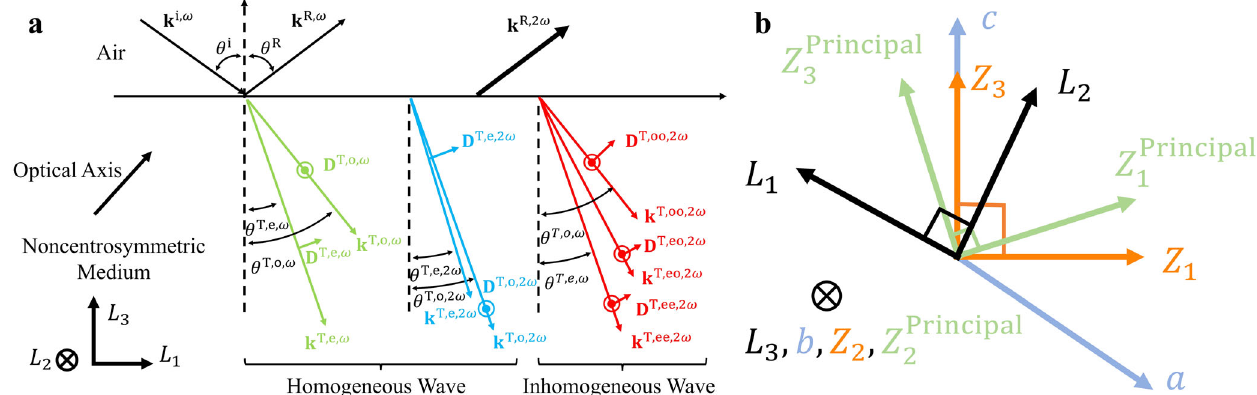
Fig. 2 Nonlinear waves and four coordinate systems for SHG process. a Schematic example of different waves at both ω and 2 ω frequencies for the speci fi c measurement geometry where the optic axes are chosen to lie in the incidence plane for clarity sake. One optical axis is shown and the other one will be in the plane as well if it is biaxial material. ♯ SHAARP does not in general have such a restriction, and can handle an arbitrary orientation of the optic axes with respect to the incidence plane. The green and blue rays are homogeneous waves at ω and 2 ω frequency. The red rays are the inhomogeneous waves at 2 ω . b Schematic of four different coordinate systems used for a monoclinic crystal structure. L 1 ; L 2 ; L 3 ð